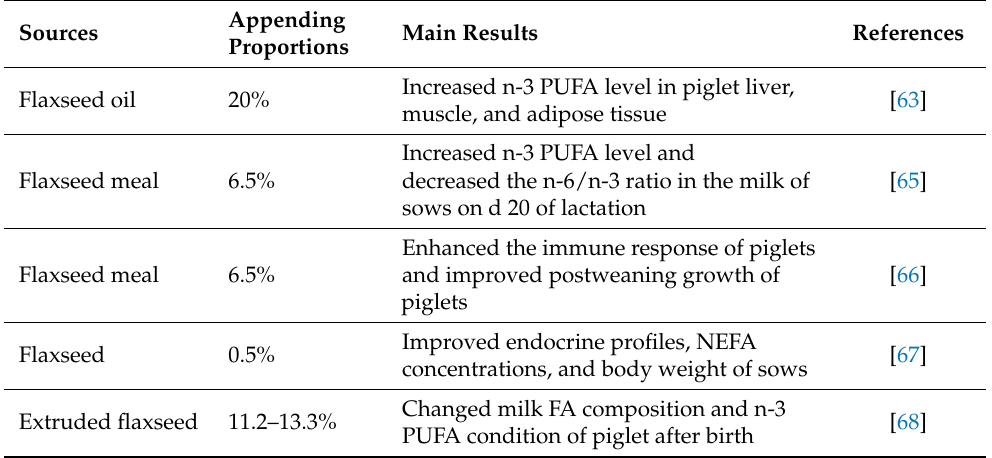
Table 5. Application of flaxseed and flaxseed meal in the